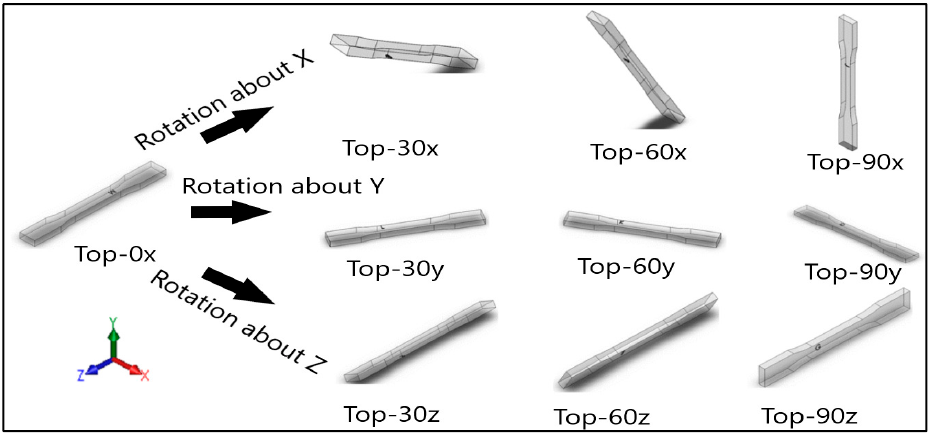
Figure 6. Isometric View of top-built samples, 0°, 30°, 60°, and 90° from left to right for each axis rotation (separate rows for x, y, and z-axis), respectively.